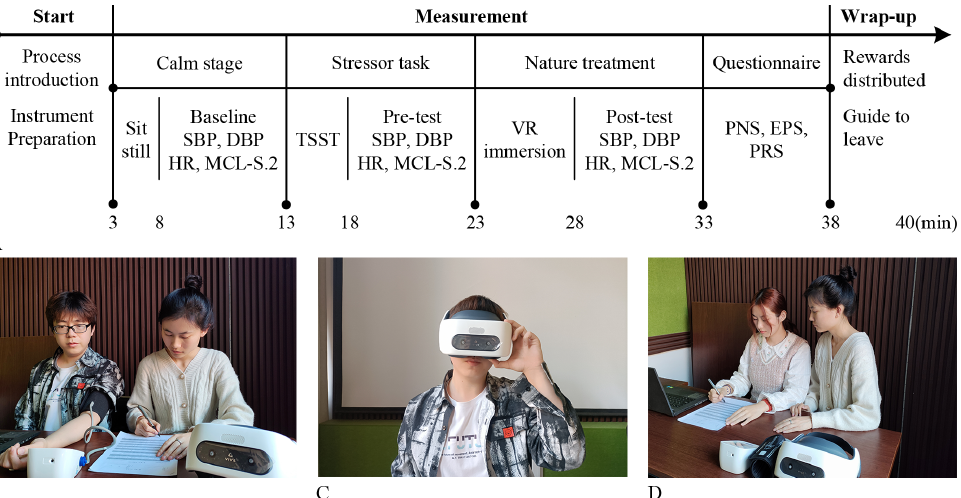
Figure 2. Schematic diagram of the experiment. ( A ) Experimental flow chart. ( B ) Measurement of physiological and psychological indicators. ( C ) Landscape VR experience for 5 min. ( D ) Completion of landscape perception evaluation questionnaires. SBP: systolic blood pressure; DBP: diastolic blood pressure; HR: heart rate; MCL-S.2: mood check list-short form.2; TSST: trier social stress test; VR: virtual reality; PNS: perceived naturalness scale; EPS: environment preference scale; PRS: perceived restorativeness scale. This figure was created by Rui Chen.